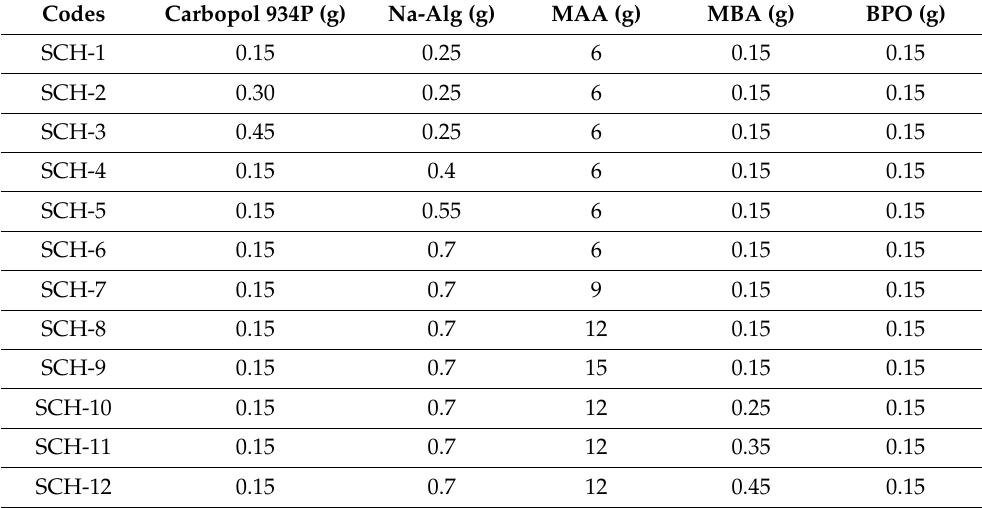
Table 1. Composition of Na-Alg/CP-co-poly (MAA) hydrogels (SCH-1 to